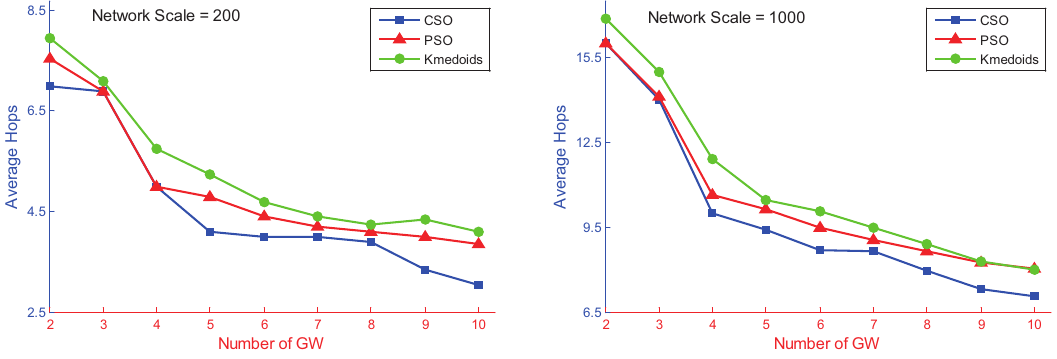
Figure 8. Number of hops of three types of algorithms at different network